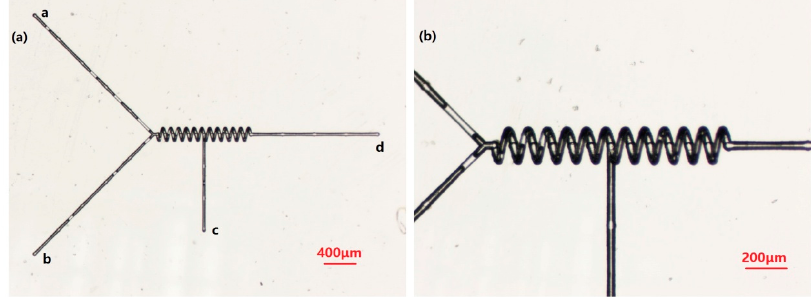
Figure 4. ( a ) Morphology of a multiple channel mixer, observed via an optical microscope; and ( b ) detail of a mixer with enlarged scale.